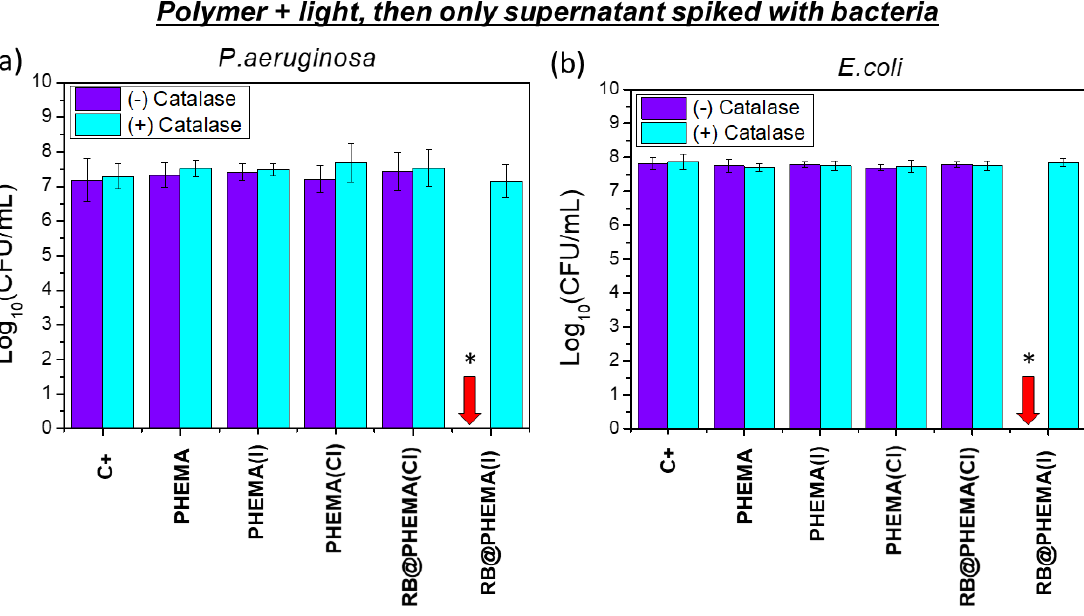
Figure 6. Bactericidal Ability of the Supernatants against P. aeruginosa ATCC 27853 ( a ) and E. coli CECT 101 ( b ). Polymers submerged in water were first irradiated for 1 h (288 J/cm 2 of total energy dose) and then removed from the solution. The remaining supernatants were split into two aliquots. One aliquot was treated with catalase ((+) catalase) and the other not ((-) catalase), and then allowed to react for 1 h. Then, each aliquot was spiked with a bacterial suspension of either P. aeruginosa ATCC 27853 and E. coli CECT 101 and incubated for 5 min. Bacterial cell survival was evaluated by counting colony-forming units (CFU) on MHA at 35 ◦ C for 24 h. The results are expressed as mean ± standard deviation. Asterisk (*) indicates significant differences ( p < 0.01). Red arrow indicates complete